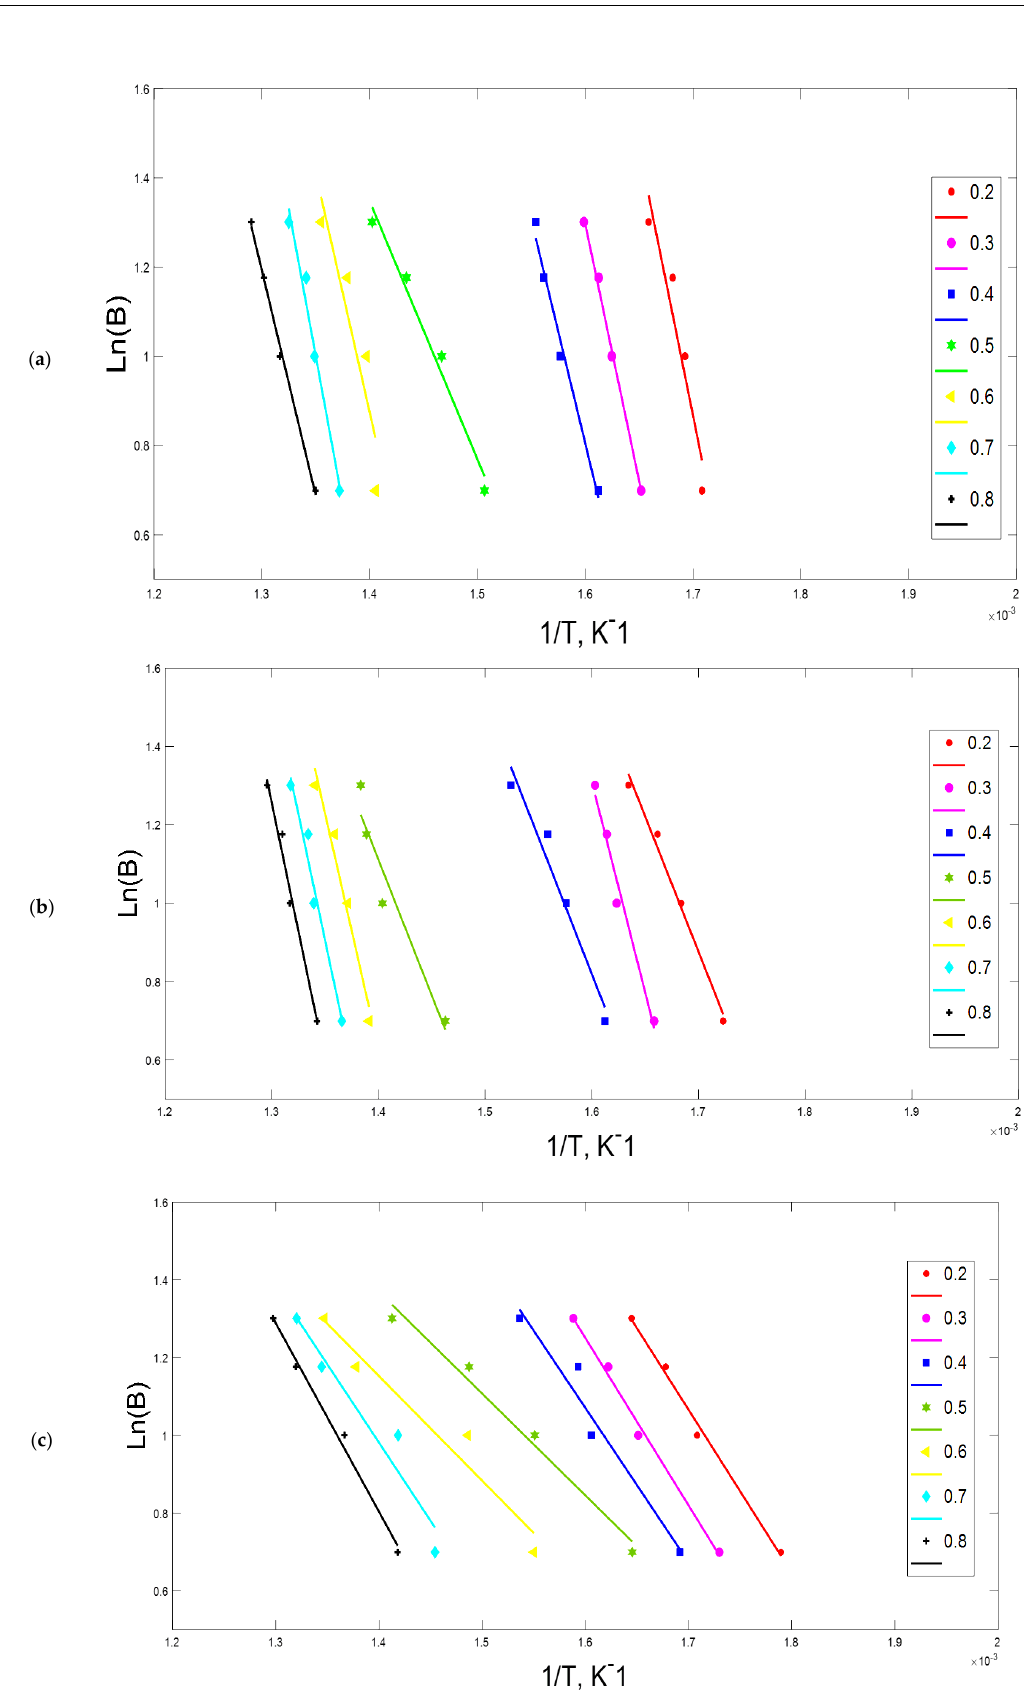
Figure 4. The approximated curves of OFW method of pyrolysis ( a ), gasification ( b ), and combustion ( c ) of Subcoal™ PAF for different values of conversion at heating rates of 5, 10, 15, and 20 °C/min.